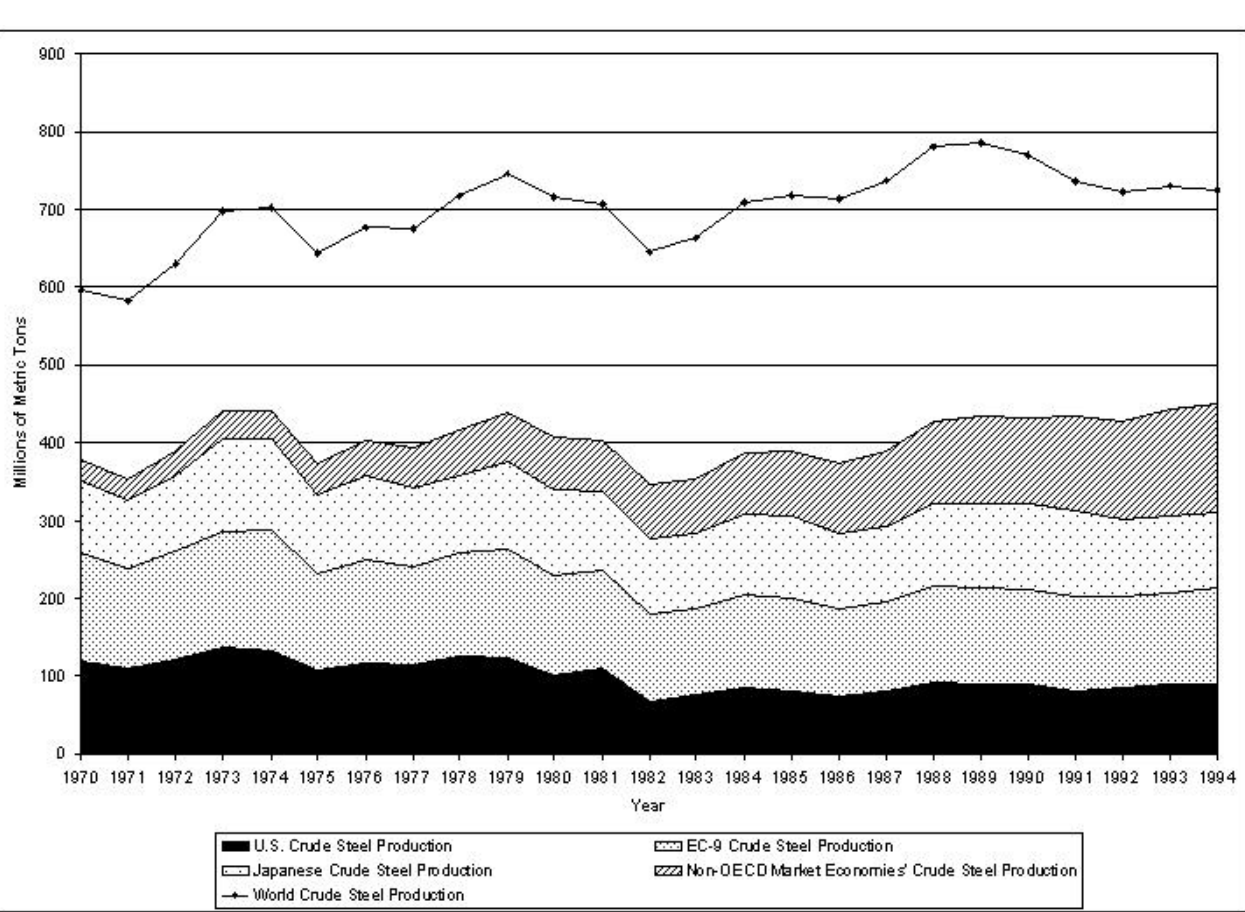
Fig. 1. World crude steel production,